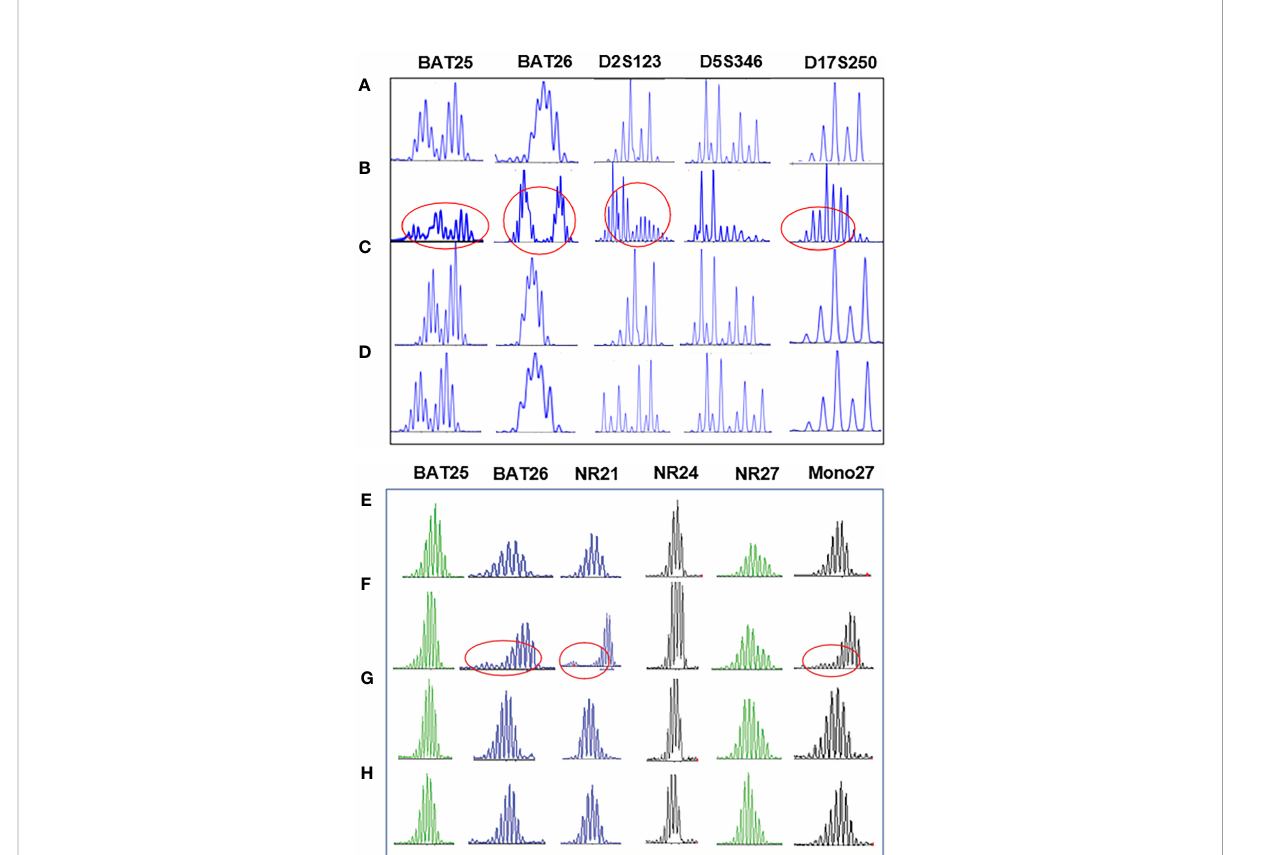
FIGURE 4 Detection results of NCI 2B3D and single nucleotide site panel of case1 based on fl uorescence quantitative PCR capillary electrophoresis. Unstable sites are displayed at the mark. (A) : Normal control tissue; (B) : In rectal adenocarcinoma tumor tissue, 2B3D panel detection revealed that BAT25, BAT26, D2S123, and D17S250 sites were unstable, and the detection result was MSI-H; (C) : In pelvic endometrial clear cell carcinoma, 2B3D panel detection demonstrated that all sites were stable, and the detection result was MSS; (D) : In the metastatic tissue of endometrial clear cell carcinoma in the right lower abdomen, 2B3D panel detection suggested that all sites were stable, and the detection result was MSS; (E) : Normal control tissue; (F) : In rectal adenocarcinoma tumor tissue, single nucleotide site panel detection implied that BAT26, NR21, and Mono27 sites were unstable, and the detection result was MSI-H; (G) : In pelvic endometrial clear cell carcinoma, single nucleotide site panel detection unveiled that all sites were stable, and the detection result was MSS; (H) : In the metastatic tissue of endometrial clear cell carcinoma in the right lower abdomen, the panel detection of single nucleotide sites uncovered that all sites were stable, and the detection result was